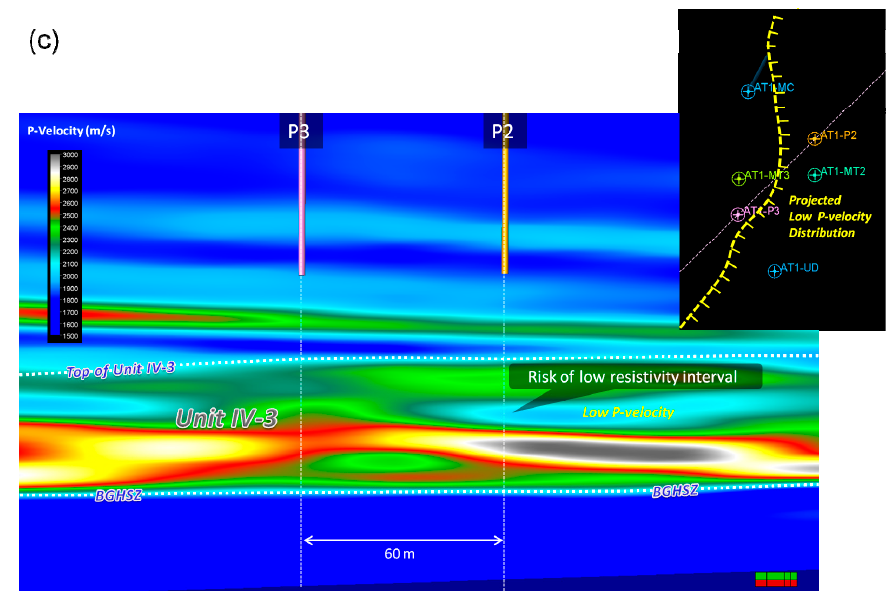
Figure 9. The results of the Vp estimated by the seismic inversion. The cross-sections are through the wells: ( a ) MC-MT3-P3-UD wells for the west side; ( b ) MC-P2-MT2-UD wells for the east side; and ( c ) P2-P3 wells for the pre-drill prediction of the reservoir quality. The projected distribution of the low Vp in the lower unit is shown by 2D plane (upper right side in Figure 9c). The vertical scale in the cross-section is two-way-time (ms).